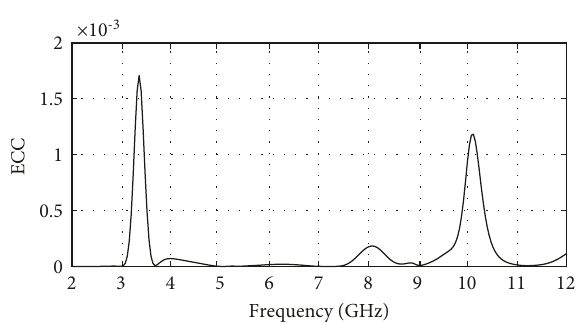
Figure 7: ECC of MIMO